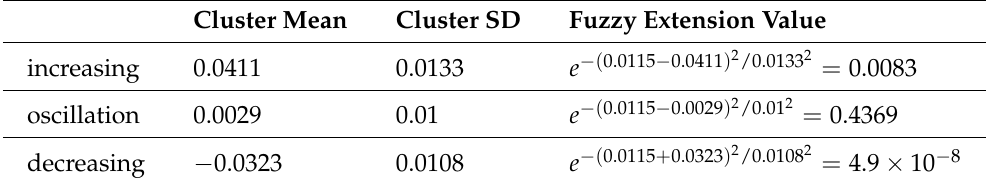
Table 1. The fourth column shows the fuzzy extension of AAPL on 8 April 2019, which was based on a daily return of 0.0115, or